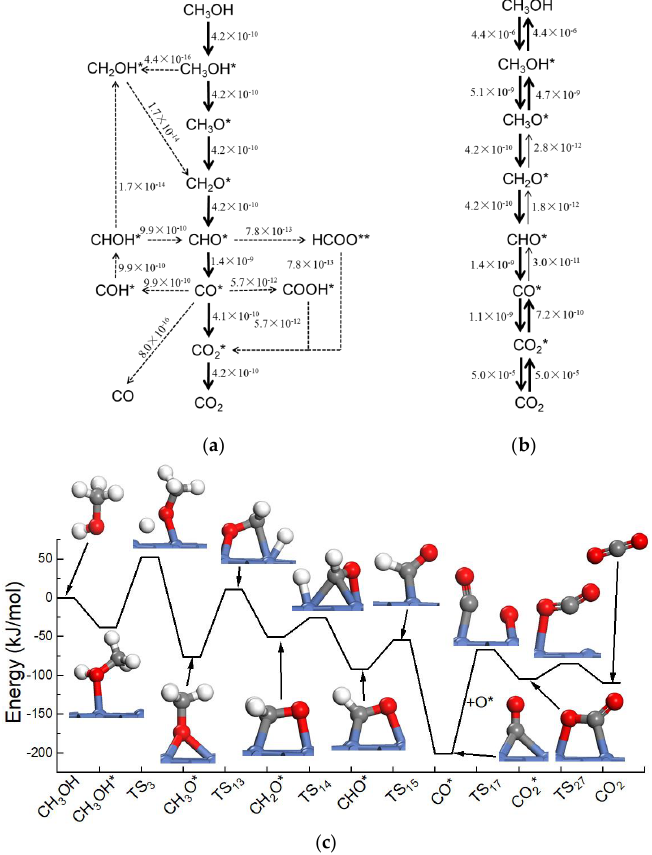
Figure 2. The reaction flux (in mol/cm 2 /s) of MSR on Ni(111) with T = 300 °C and P CH3OH : P H2O = 1:3. ( a ) The net reaction rate of carbon-containing elementary reactions, where the solid lines indicate the main reaction path and the dash lines refer to the secondary pathway, ( b ) the forward and reverse reaction rate of elementary steps in the main pathway, where the bold arrow indicates the reaction rate is greater than 4 × 10 −10 mol/cm 2 /s, ( c ) energies and structures of reacting species, except H* and H 2 , and transition states in the main reaction pathway. TS i in the figure denotes the transition state of Reaction i shown in Table 2.